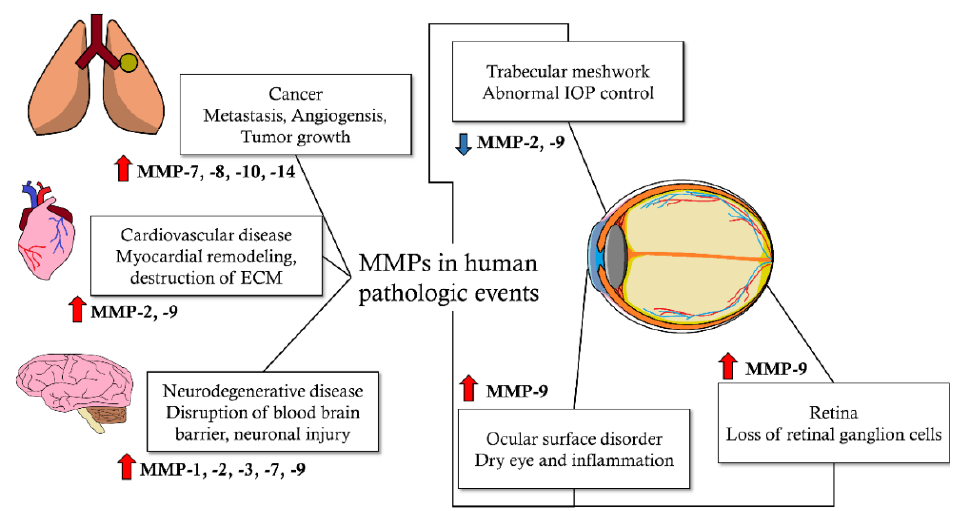
Figure 1. Effect of matrix metalloproteinases (MMPs) on human pathologic events [12–17]. In cancer, metastasis, angiogenesis, and tumor growth are affected by upregulated MMP-7, -8, -10, and -14 activity. Myocardial remodeling and extracellular matrix (ECM) destructions occur in cardiovascular disease by increased MMP-2 and -9 activity. Neuronal injury and disruption of the blood–brain barrier is caused by elevated MMP-1, -2, -3, -7 and -9 activity in neurodegenerative disease. Additionally, in the eye, increased MMP-9 activity affects ocular surface disorder, which can cause dry eye and surface inflammatory change. Furthermore, increased MMP-9 activity can cause retinal ganglion cell death in the retina. Decreased MMP-2 and -9 activity can disrupt homeostasis of intraocular pressure (IOP) in trabecular meshwork.